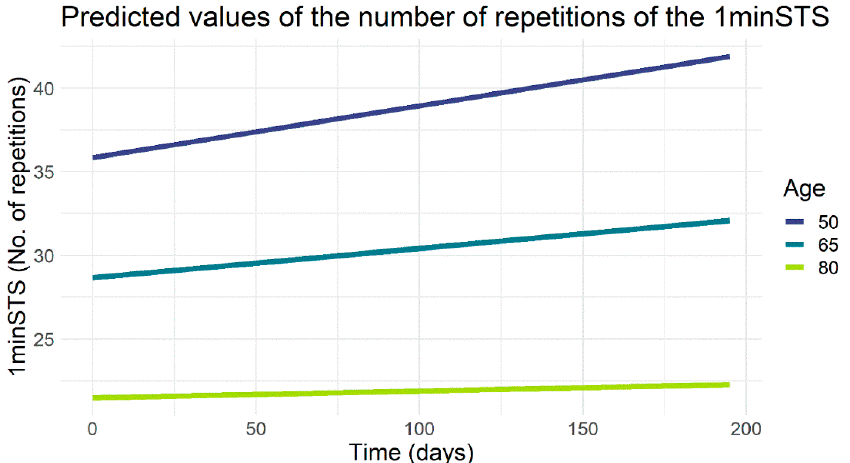
Figure 2. Predicted values for the number of repetitions in the one-minute sit-to-stand test (1minSTS) in participants with chronic obstructive pulmonary disease. According to the model, the 1minSTS values were adjusted for male participants, body mass index of 25, mild Charlson comorbidity index score, 53.31% predicted of forced expiratory volume in one-second, and a score of 2 in the modified British medical research council dyspnoea scale.